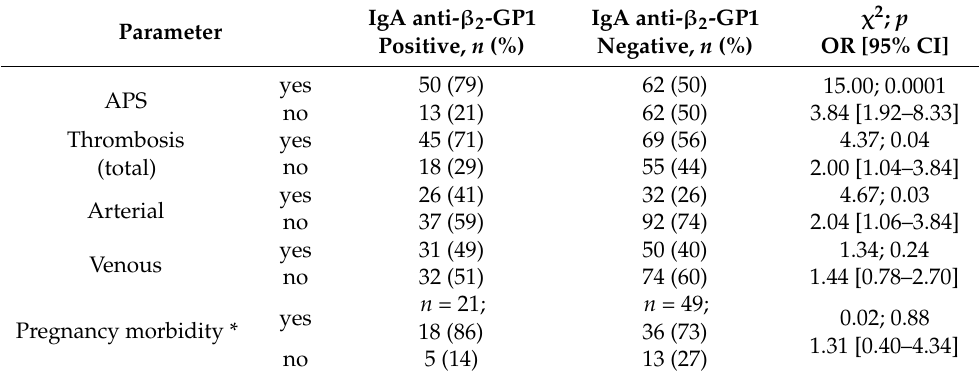
Table 2. Relationship of antiphospholipid syndrome and it is clinical manifestations (thrombosis and pregnancy morbidity) with IgA antibodies to beta-2 glycoprotein 1 (IgA anti- β 2 -GP1).